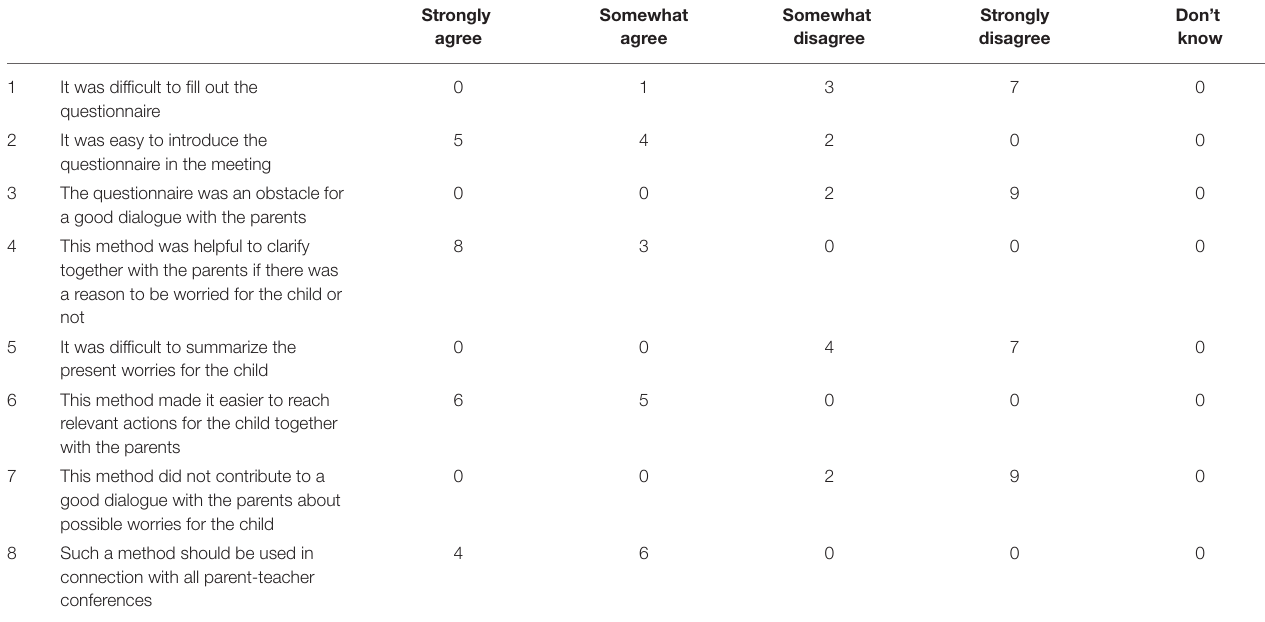
TABLE 3 | User satisfaction, teacher questionnaires completed after final testing round in 2019 ( N =